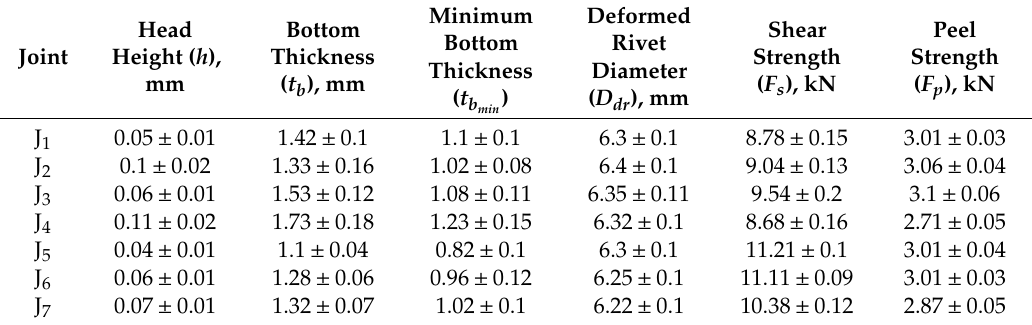
Table 4. SPR joint specifications, including interlocking parameters and